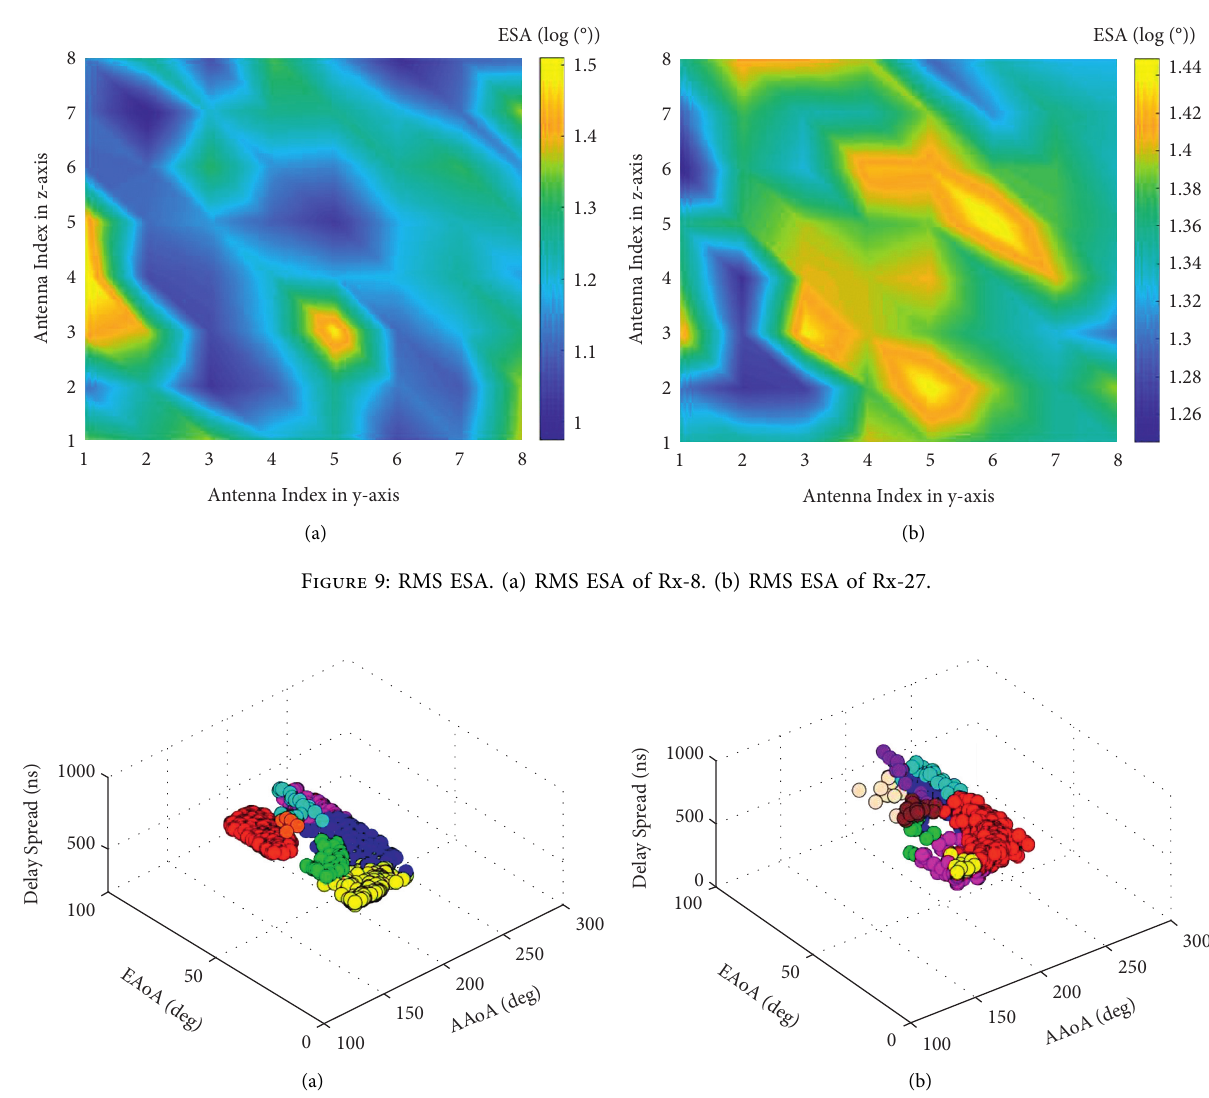
Figure 10: Clustered MPCs. (a) Rx-8 in LOS scenarios. (b) Rx-27 in NLOS